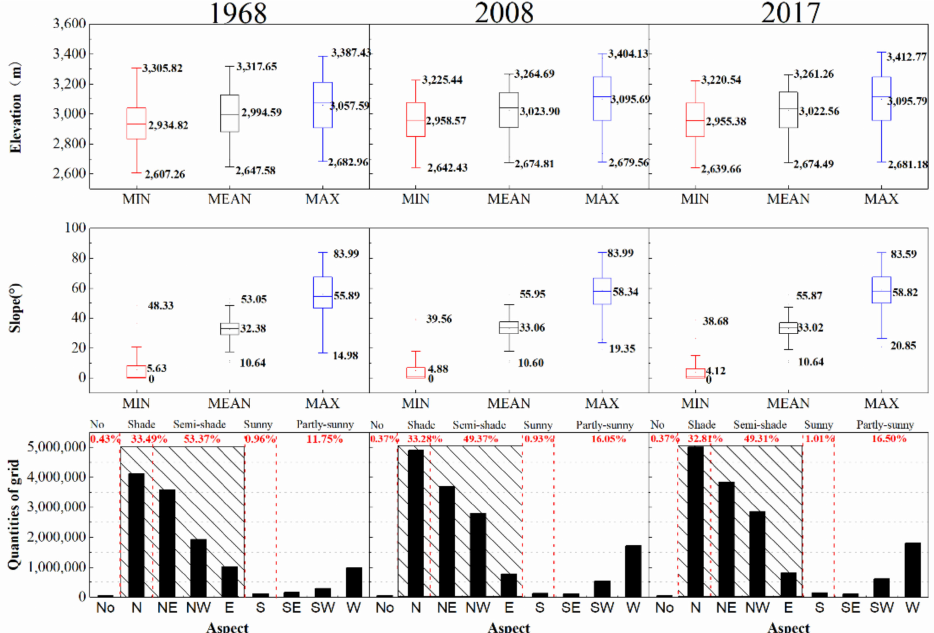
Figure 6. Elevation, slope, and aspect features of Picea crassifolia Kom. forest